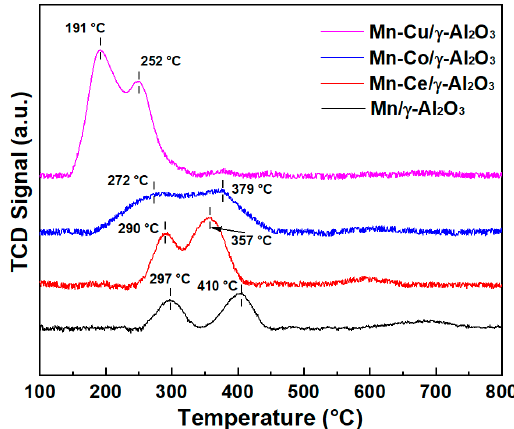
Figure 3. H 2 -TPR profiles of Mn-X/ γ -Al 2 O 3 catalysts.